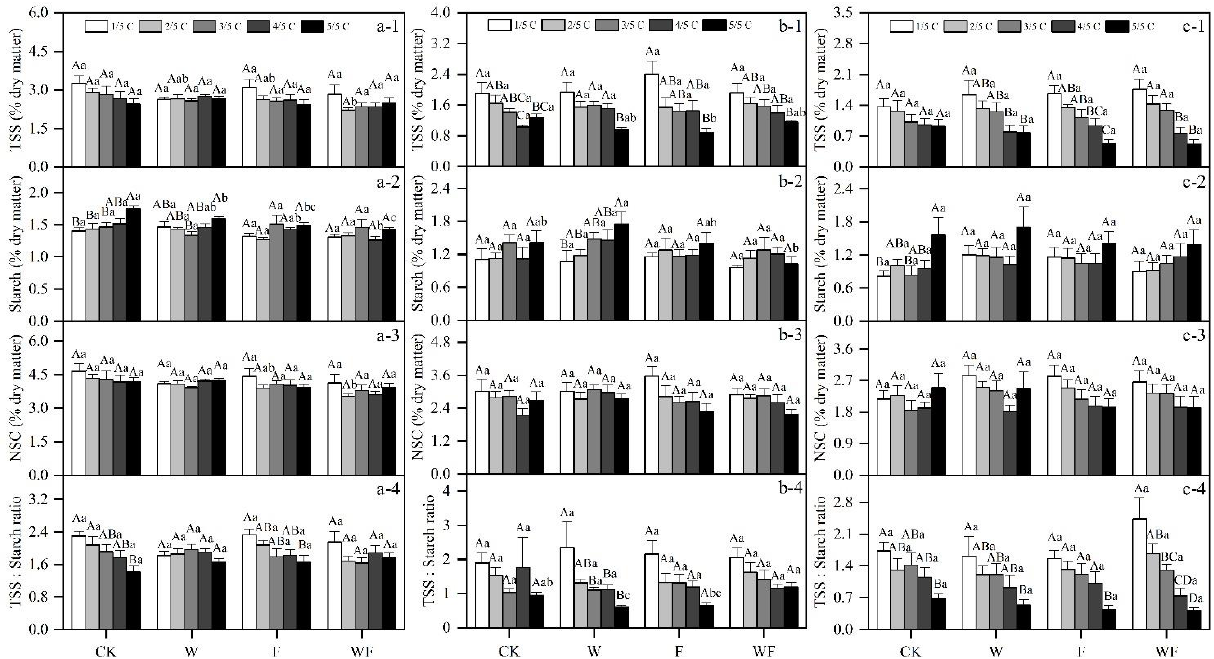
Figure 2. Changes in TSS, starch, NSC concentration and ratio of TSS to starch in the canopy of E. urophylla × E. grandis under different treatments. The average value and standard error of each time are shown (n = 5). The a , b , c represent the leaf, branchlet and old branch. Numbers 1 – 4 indicate the concentrations of TSS, starch, NSC and the ratio of TSS to starch, respectively . The letters over the bars represent the results of Duncan’s multiple comparison analysis. Different capital letters indicate significant differences between different canopy heights (C) under the same treatment ( p < 0.05). Different lower-case letters indicate significant differences between different treatments for the same tissues ( p < 0.05).